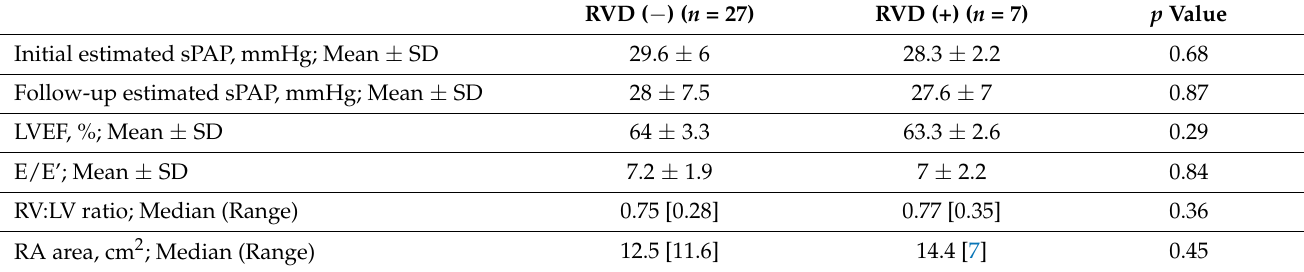
Table 3. Preoperative and follow-up echocardiography parameters in liver transplant